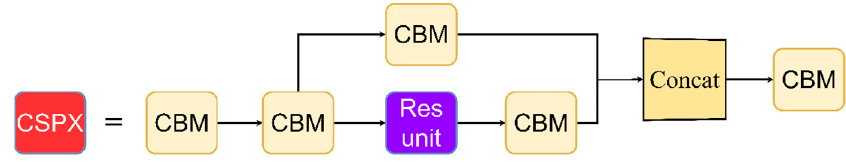
Figure 4. CSPX unit module.